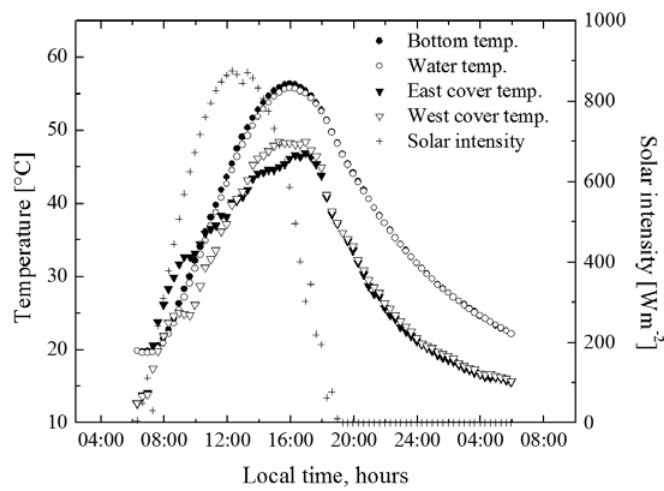
Figure 10. Experimental temperatures measured at each component of a double-slope condenser solar still (Reprinted from [19], with permission from Elsevier, 2019).